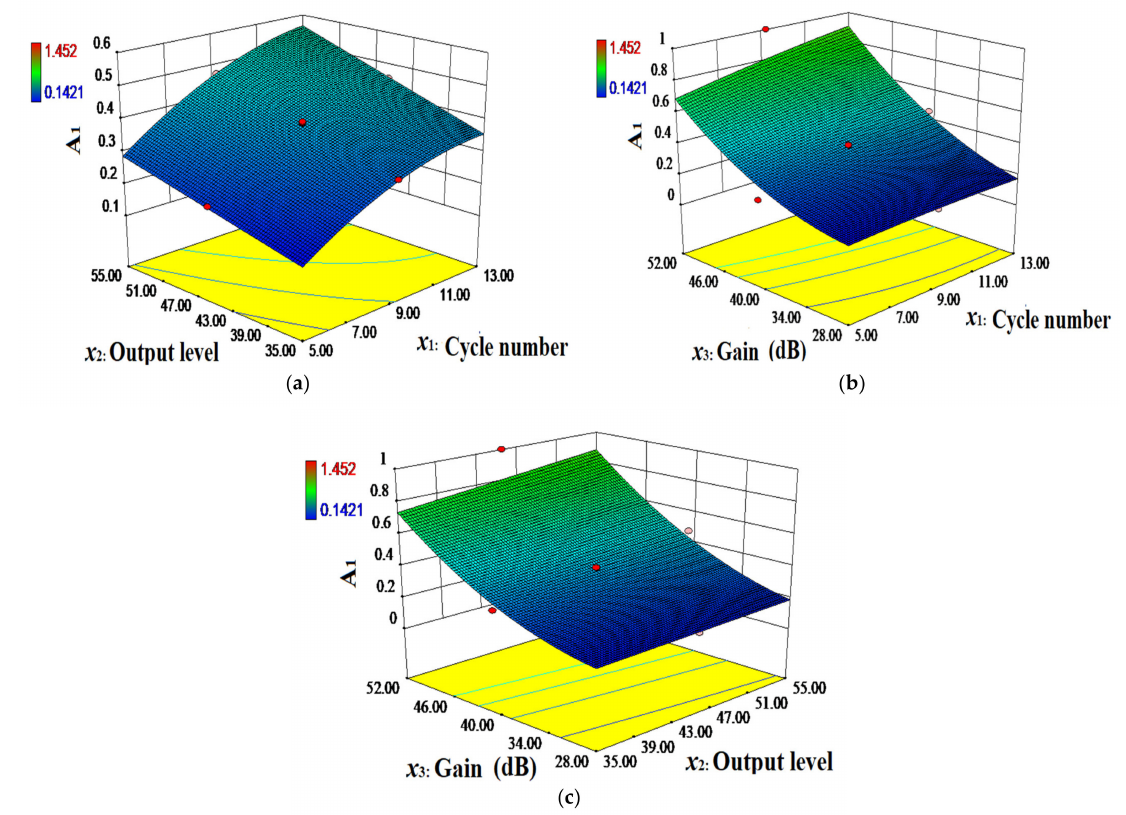
Figure 10. Three-dimensional (3D) response plots: ( a ) Cycle number ( x 1 ) and output level ( x 2 ), ( b ) cycle number ( x 1 ) and gain ( x 3 ), ( c ) output level ( x 2 ) and gain ( x 3 ), and their mutual interactions with A 1